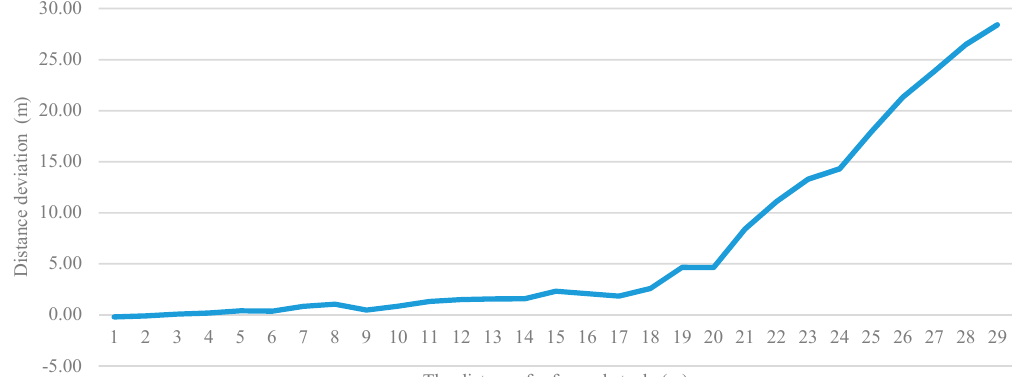
Figure 19. Deviation between calculated distance and actual distance.